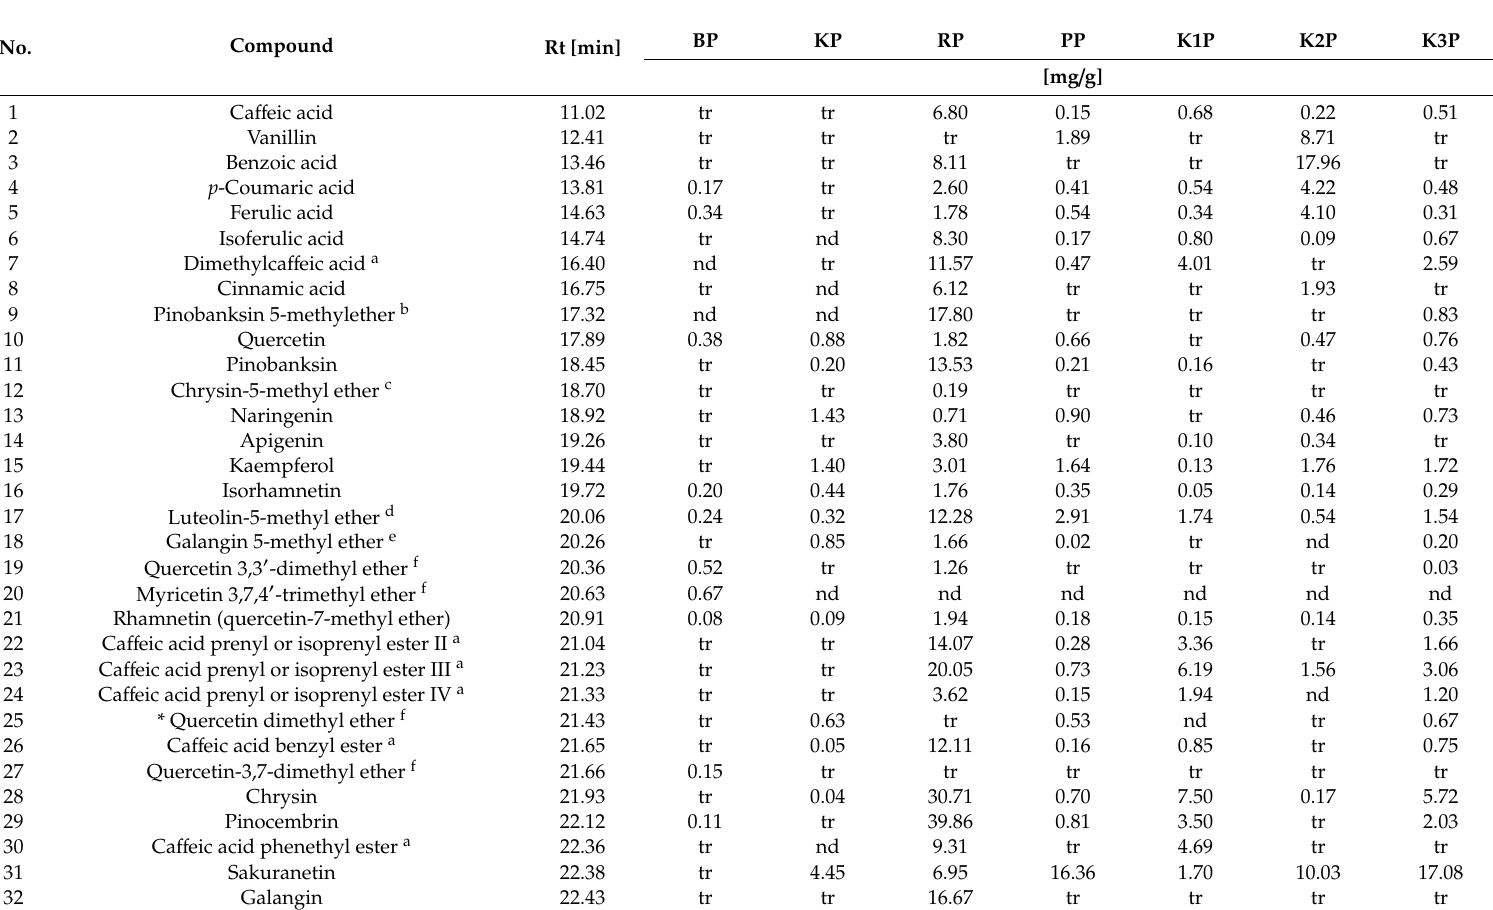
Table 4. Quantities of the selected compounds identified by UHPLC-DAD-QqTOF-MS in extracts of Croatian propolis samples.